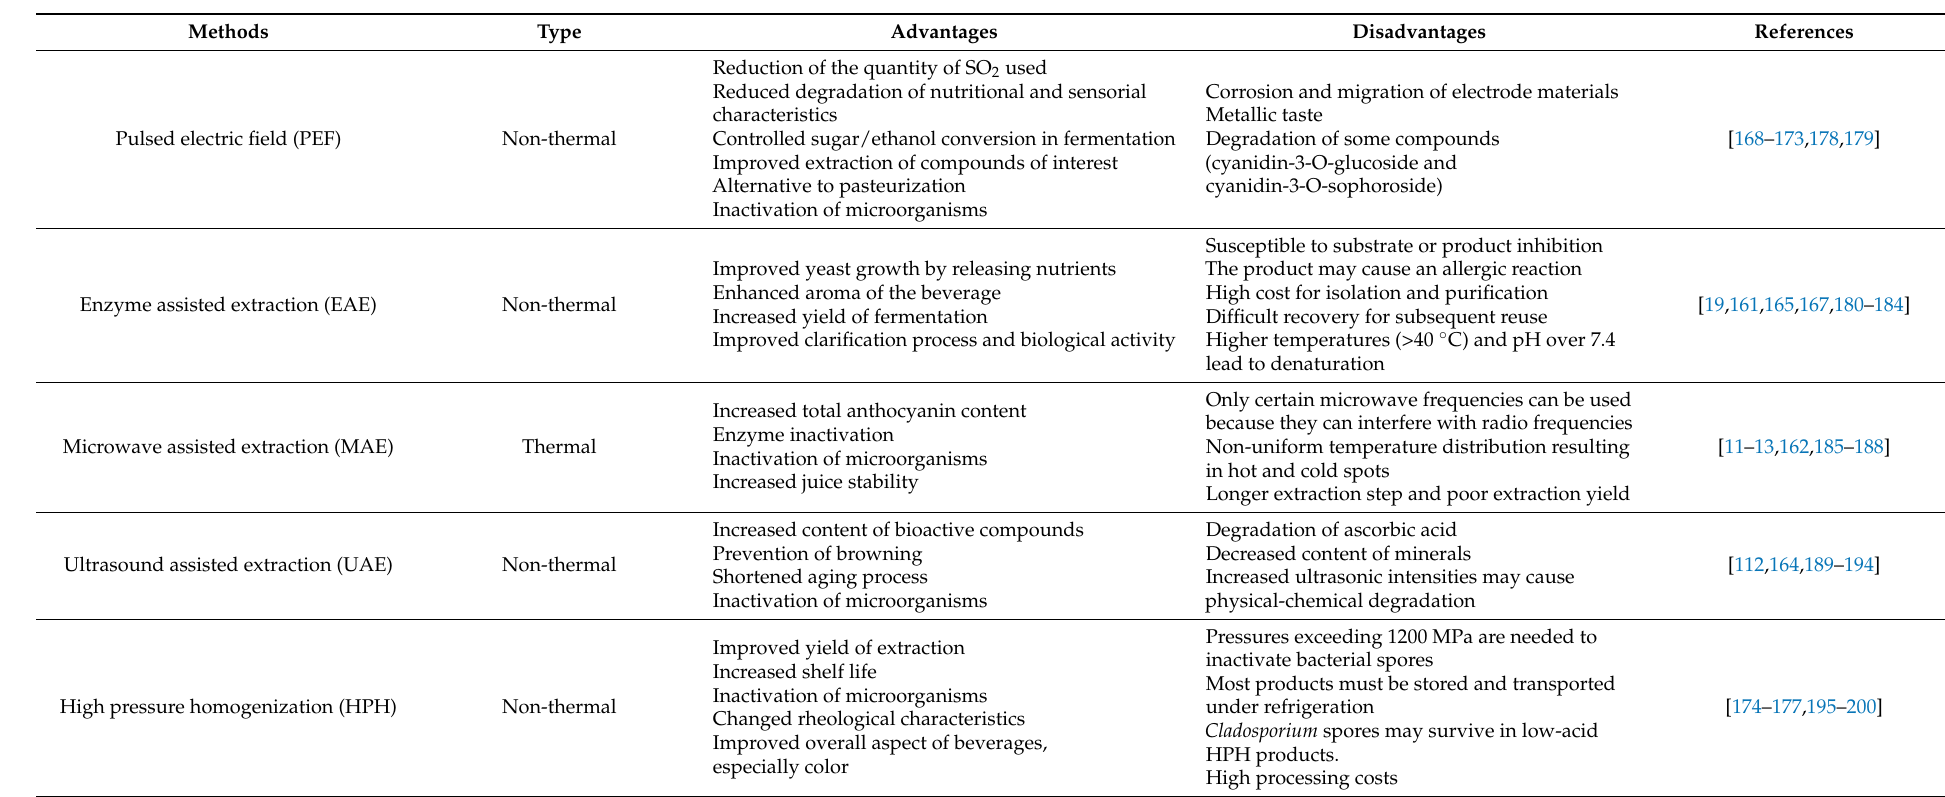
Table 4. Advantages and disadvantages of methods to improve the functional potential of fruit-based fermented